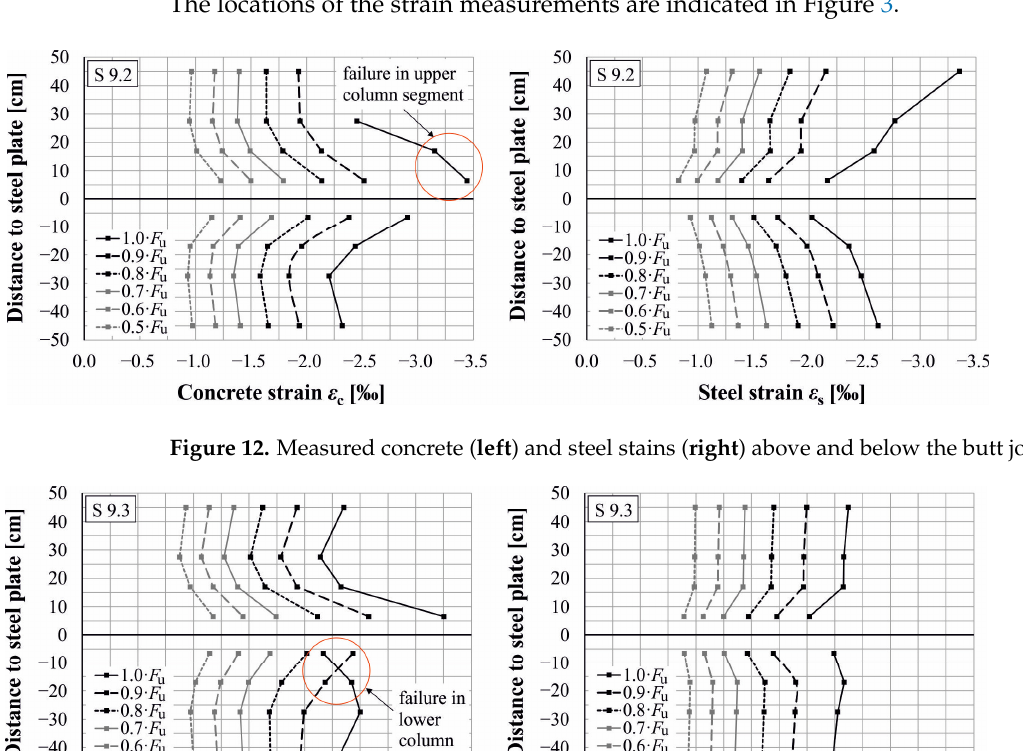
Figure 13. Measured concrete ( left ) and steel stains ( right ) above and below the butt joint for S 9.3.